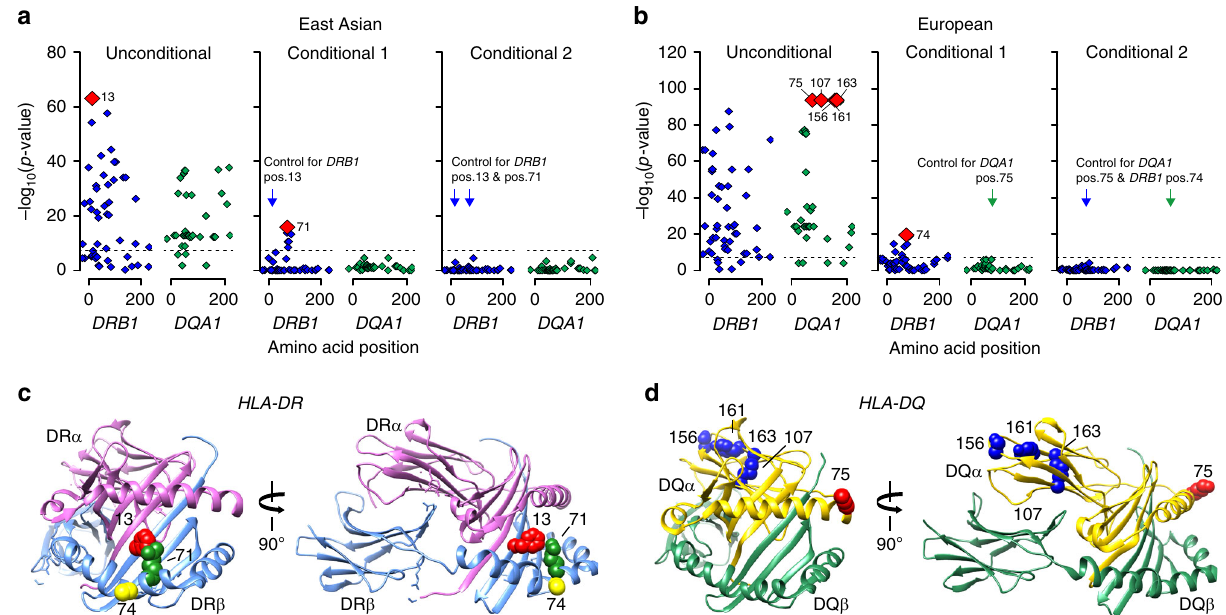
Fig. 3 Ethnicity-speci fi c association analyses of DR β 1 and DQ α 1 amino acid sequence. a East Asian analysis of polymorphic amino acid positions within DR β 1 (blue) and DQ α 1 (green) molecules using conditional haplotype tests; the horizontal dash line marks the genome-wide signi fi cance level. The most strongly associated polymorphic site was position 13 in DRB1 (left panel); after controlling for this position, position 71 in DRB1 remained genome-wide signi fi cant (middle panel); after adjusting for both positions, there were no residual associations (right panel). b European analysis of polymorphic amino acid positions within DR β 1 (blue) and DQ α 1 (green); the DQA1 haplotype de fi ned by amino acid positions 75, 107, 156, 161 and 163 (left panel) provided the strongest signal; after conditioning on this haplotype, position 74 in DRB1 remained genome-wide signi fi cant (middle panel); no additional independent positions were found upon further conditioning (right panel). c Protein structure of the DR molecule including α chain (pink ribbon) and β chain (blue ribbon), the side chains of amino acids at DR β 1 positions 13, 71, and 74 are located adjacent to each other in the P4 pocket of the peptide-binding groove. d Protein structure of the DQ molecule including α chain (yellow ribbon) and β chain (green ribbon); all fi ve bi-allelic amino acid sites in DQ α 1 are in perfect LD with each other and de fi ne the top associated DQA1*0501 allele in